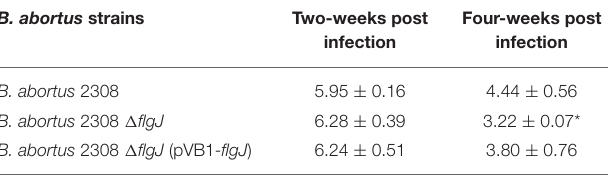
TABLE 3 | Spleen colonization of BALB/c mice with B. abortus wild-type 2308, B. abortus 2308 1 flgJ mutant, and complemented B. abortus 2308 1 flgJ (pVB1- flgJ )